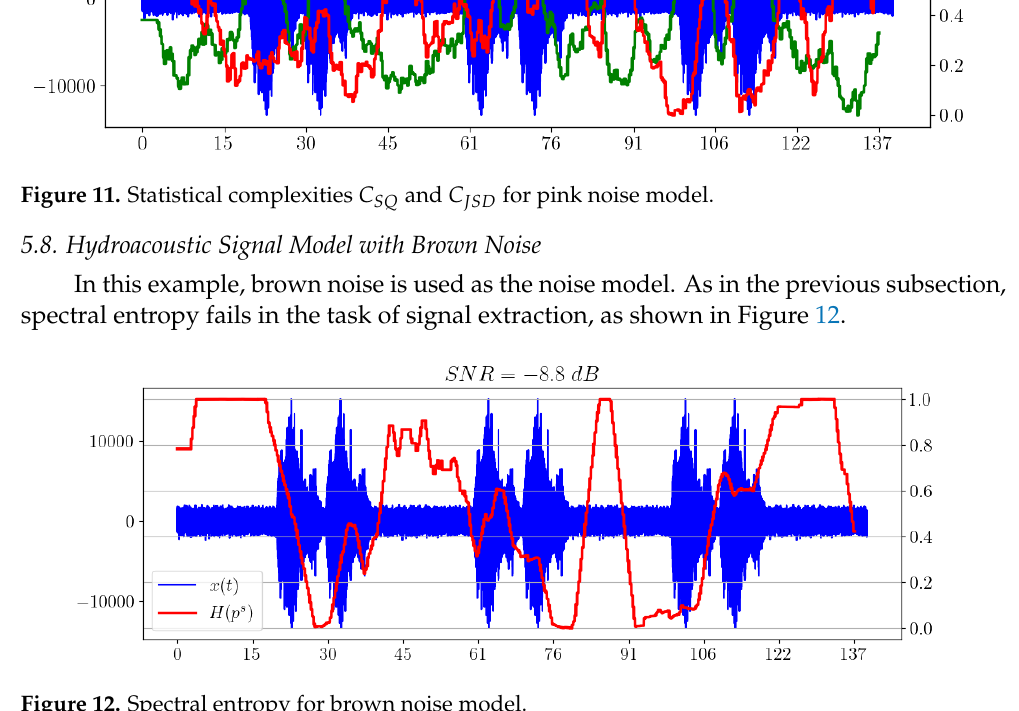
Figure 12. Spectral entropy for brown noise